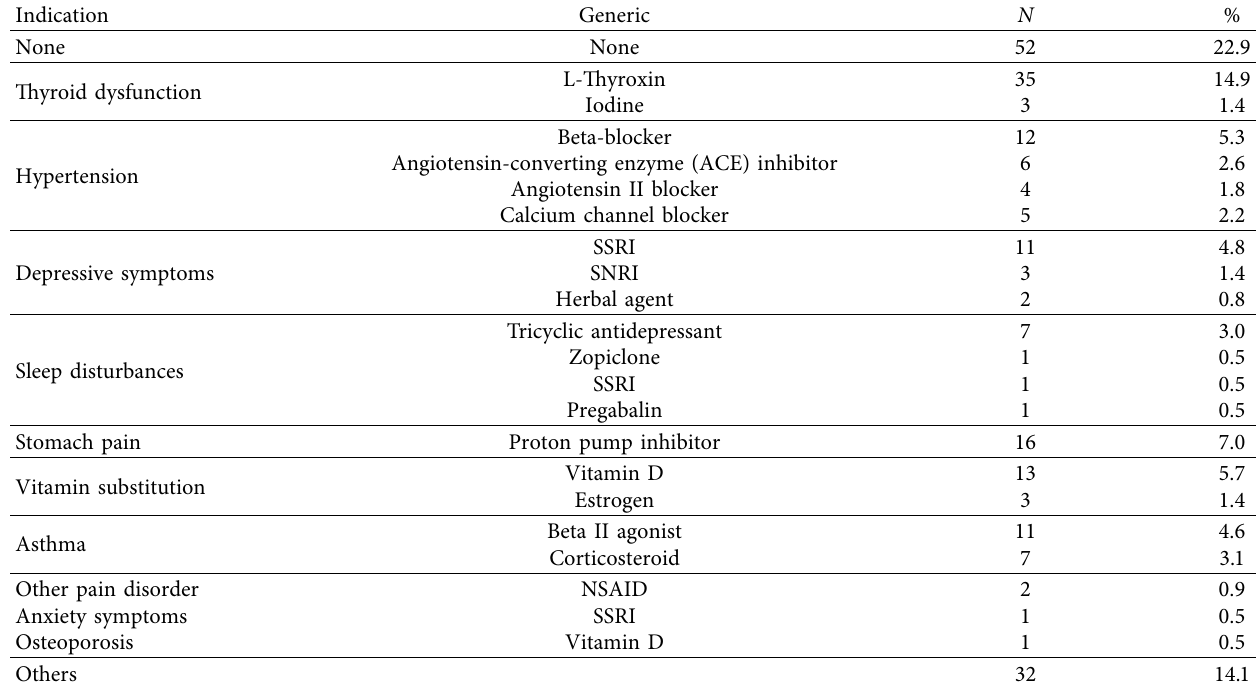
Table 7: Concomitant medications and their